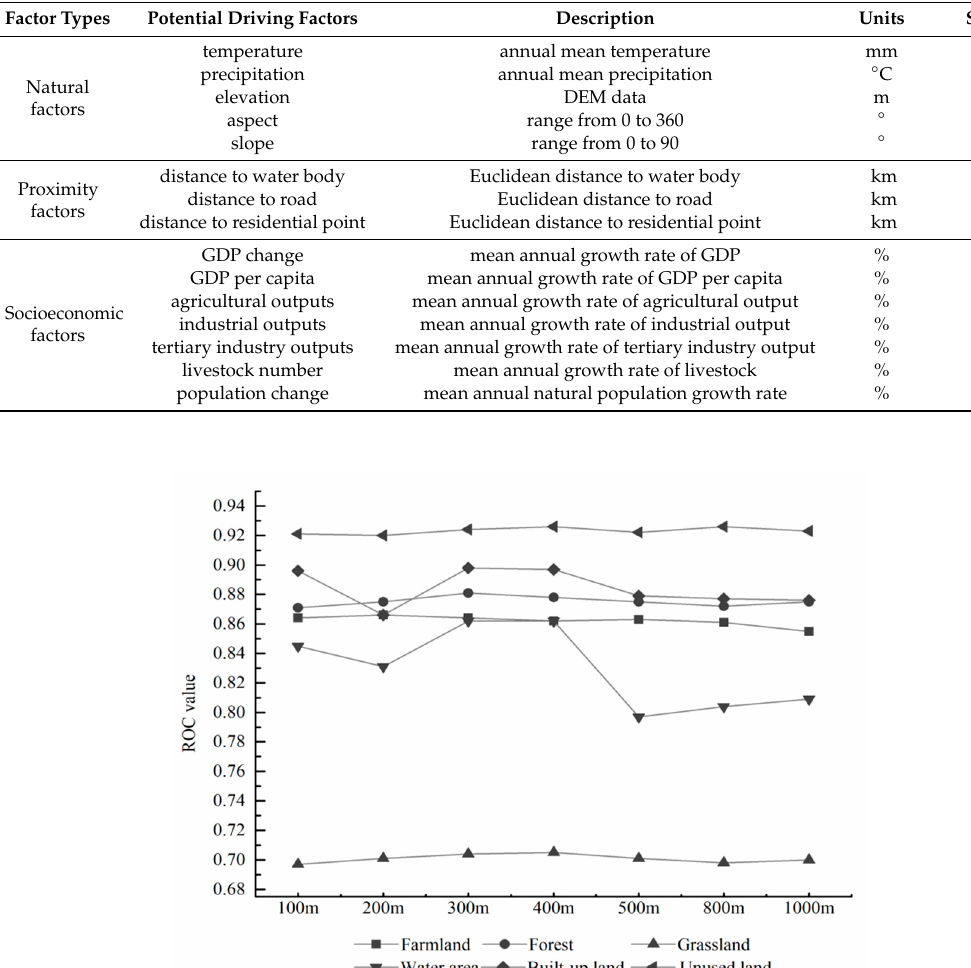
Table 1. Potential driving factors.